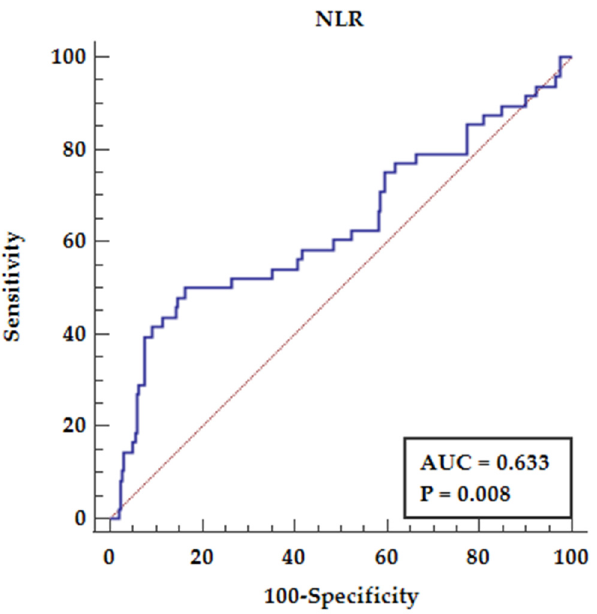
Figure 3. Receiver operator characteristics for NLR and tacrolimus overdose (>15 ng/mL). The ROC curve analysis of the NLR for predicting tacrolimus overdose. Abbreviations: NLR—neutrophil to lymphocyte ratio.